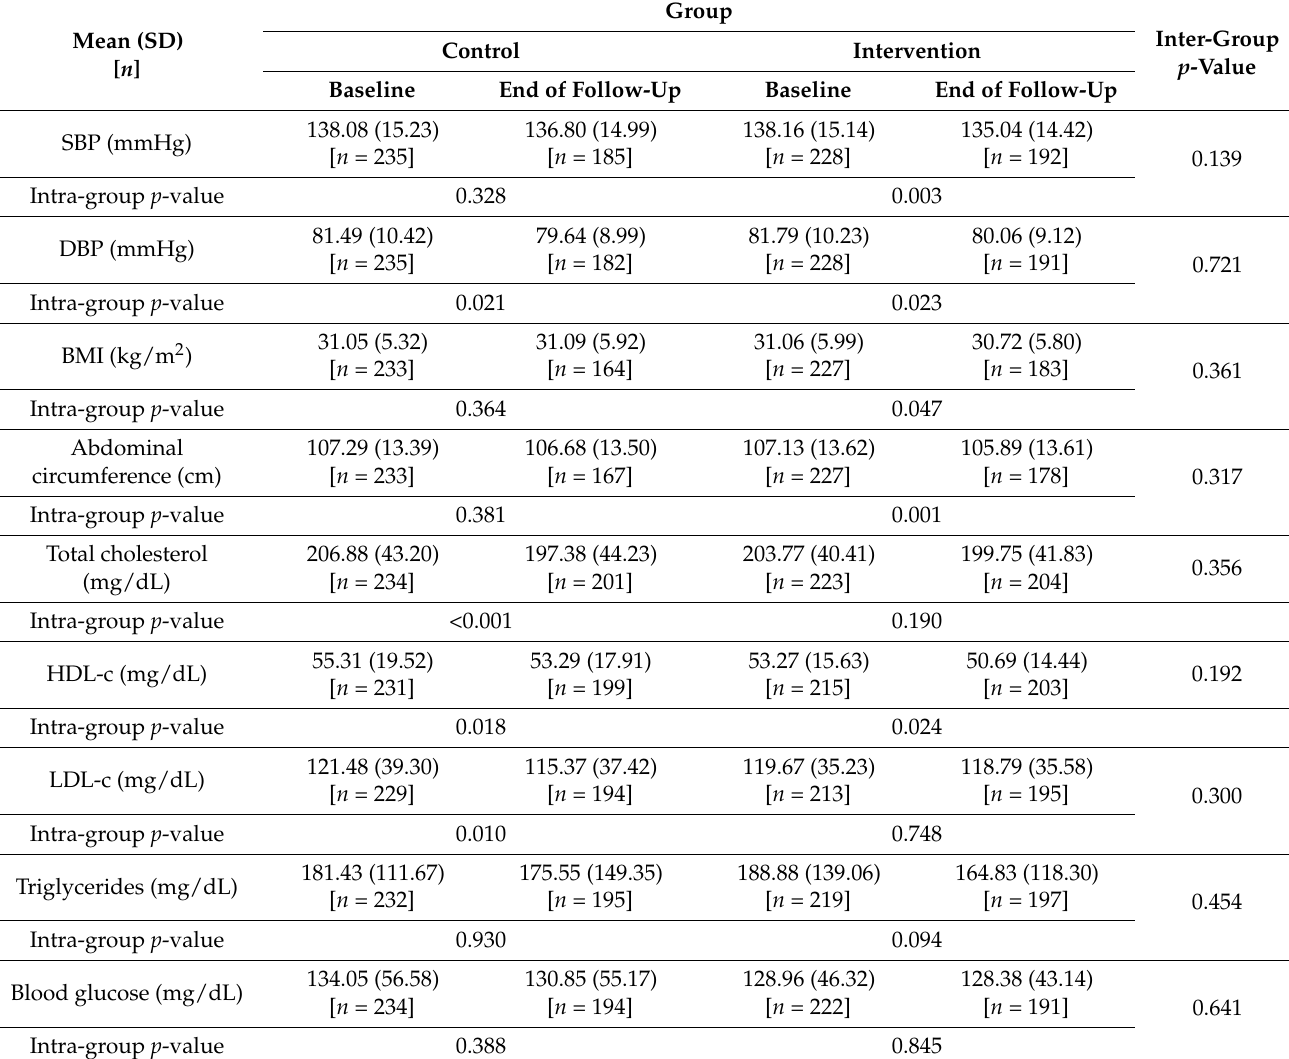
Table 2. Intragroup and intergroup comparison of risk factors and anthropometric